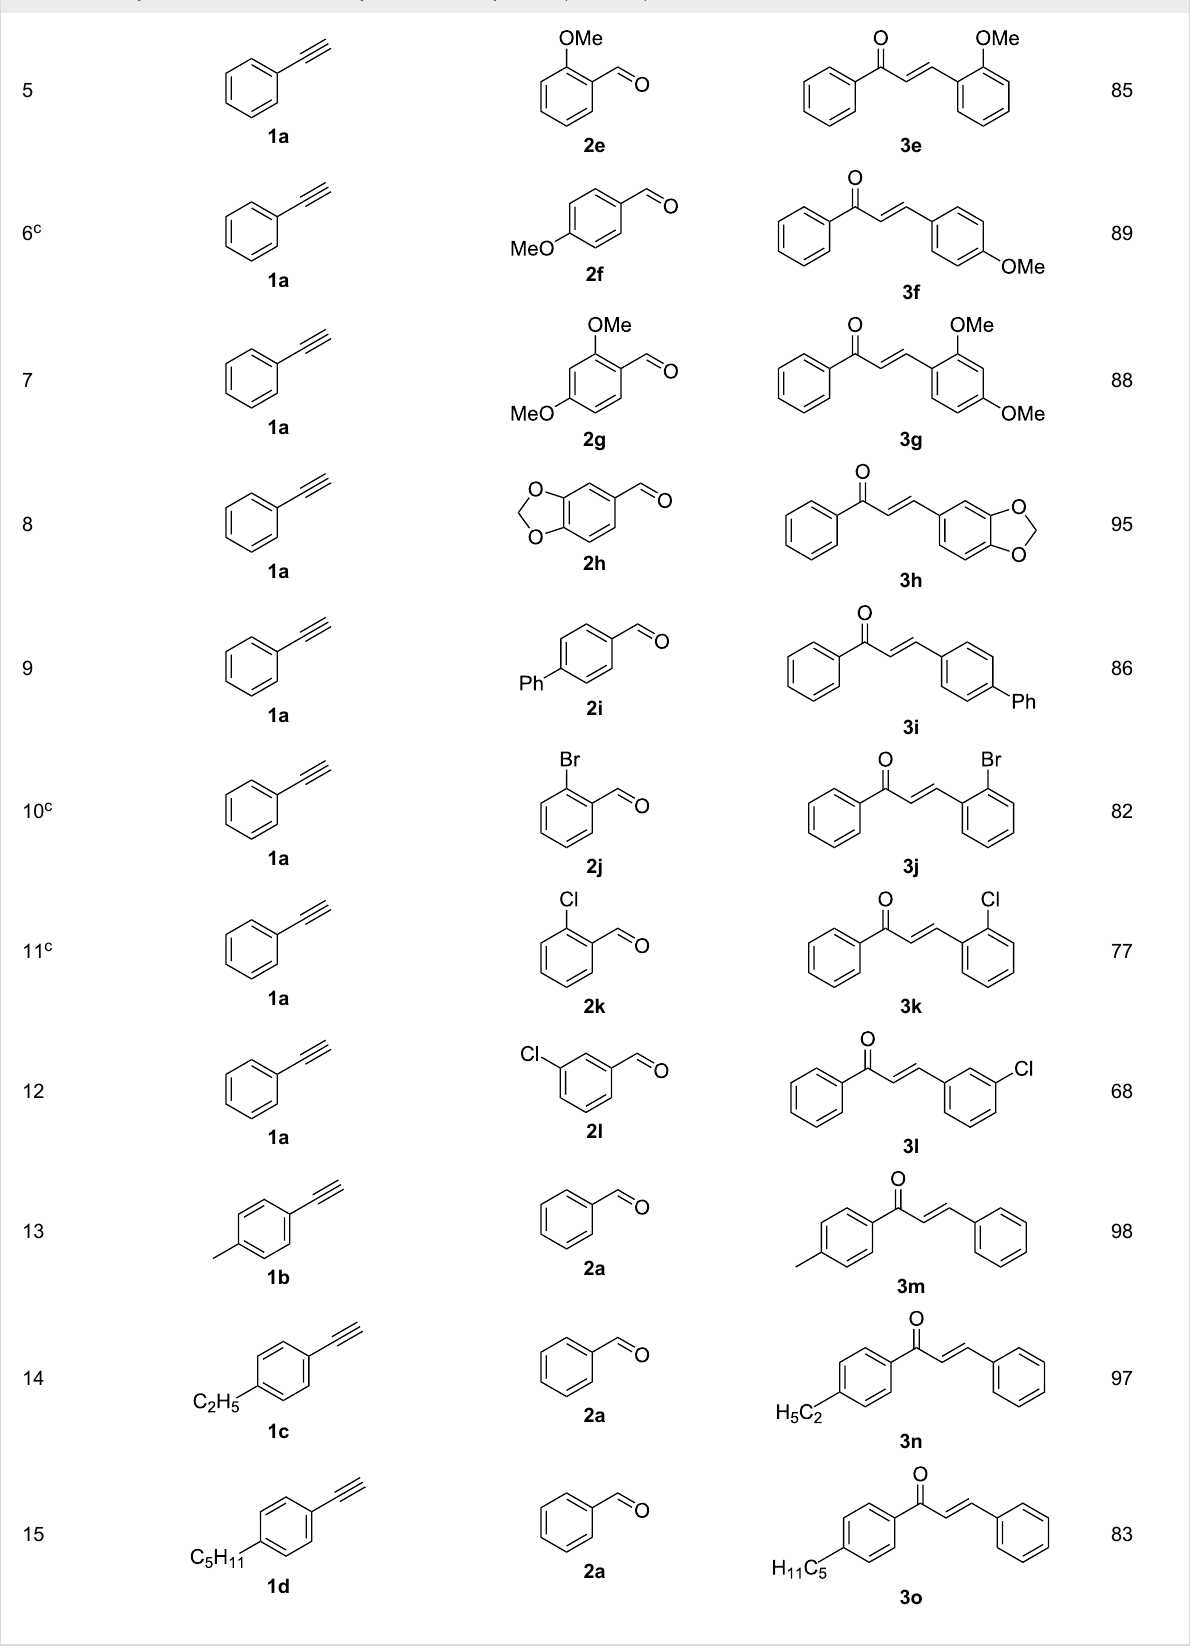
Table 2: Flow hydration–condensation of alkynes 1 and aldehydes 2 . a